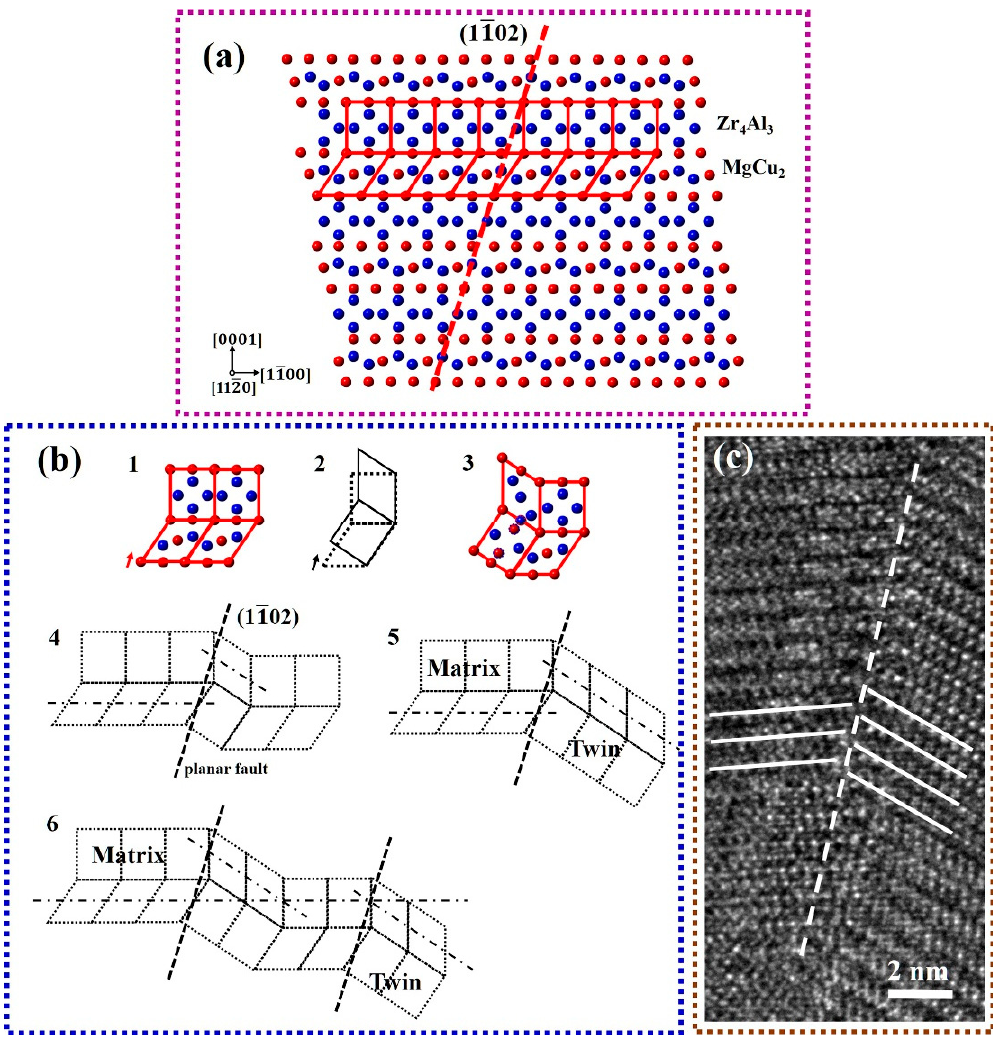
Figure 5. ( a ) The atomic arrangement of μ phase, consisting of rectangular (Zr 4 Al 3 ) and quadrilateral (MgCu 2 ) structures as periodic units; ( b ) schematic illustration of (1 1(cid:3364) 02) μ twinning mechanism in the μ phase, where red and black arrows in b1 and b2 show the shear direction; and ( c ) HRTEM image of (1 1(cid:3364) 02) μ twins in the μ phase.